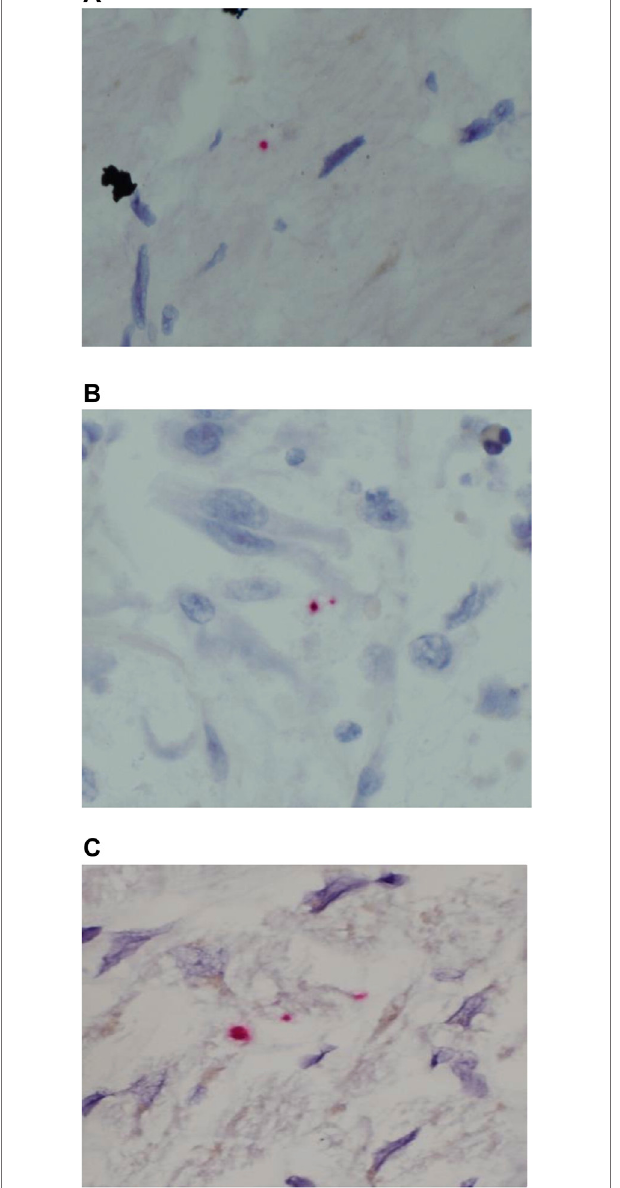
FIGURE 6 | SARS-CoV-2 ISH in myocardium from the autopsy of patients who died secondary to COVID-19 infection. (A – C) Positive reactions for the probes directed against SARS-CoV-2 S-protein (red dot) original magni fi cations × 400).